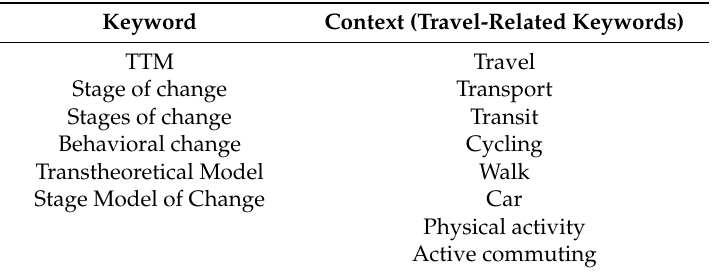
Table 2. Keywords and travel-related keywords used in the review.